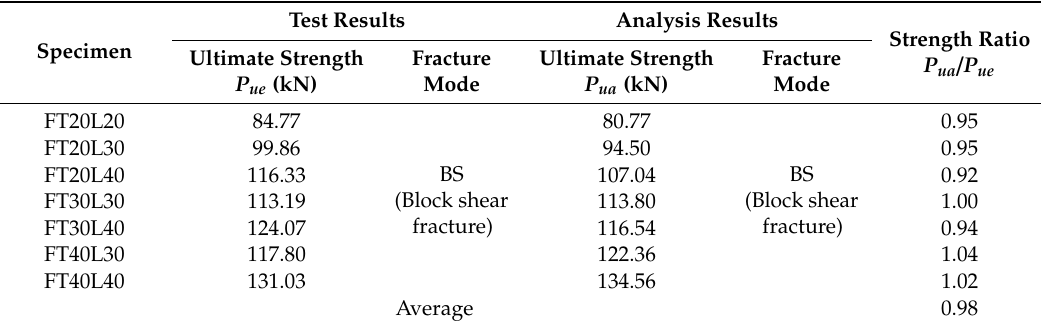
Table 2. Comparison of test and finite element (FE) analysis